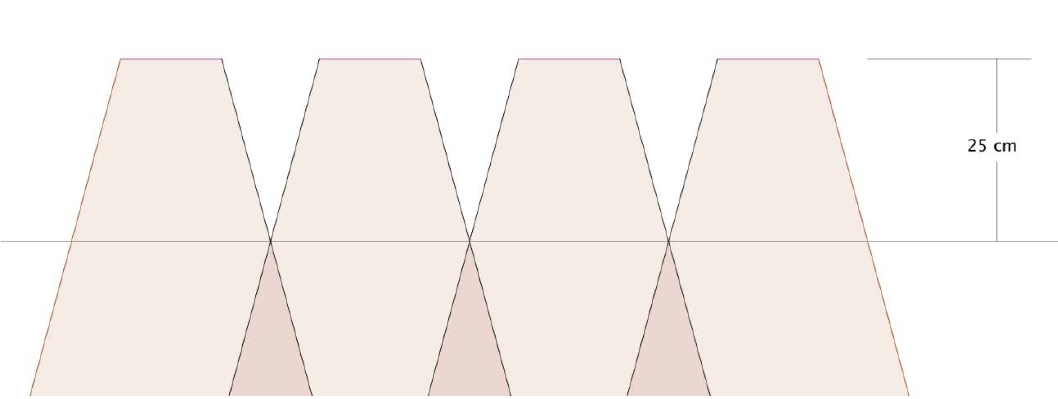
Fig. 1 Front view of the lamp